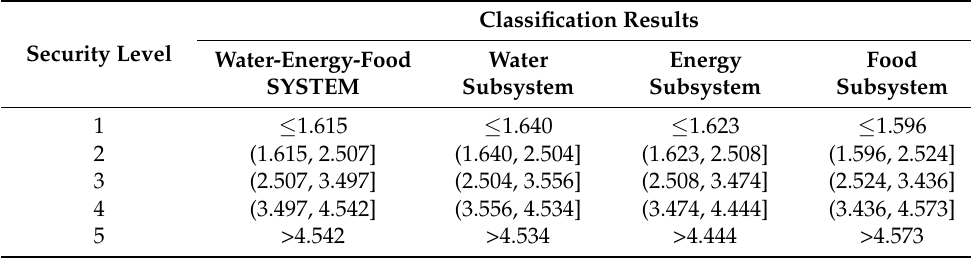
Table 3. Classification results of security evaluation of each